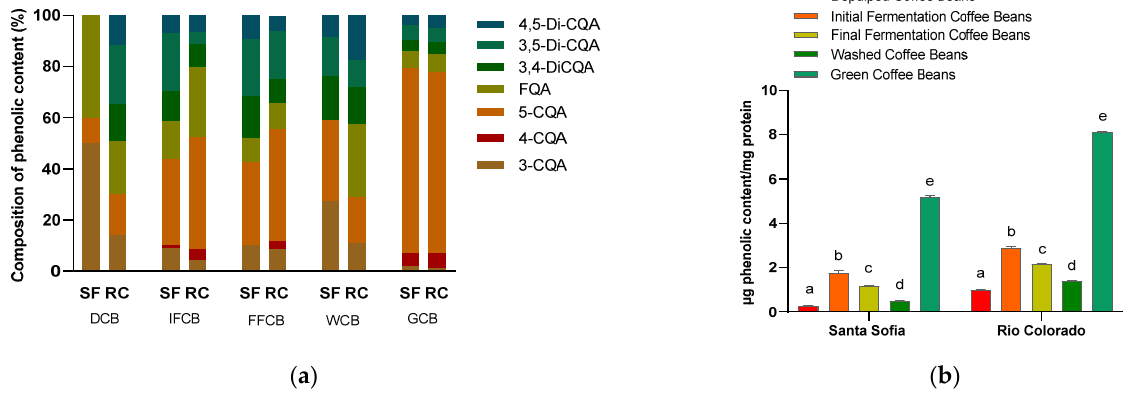
Figure 3. Phenolic compounds in protein extract. ( a ) Composition of the major phenolic compounds expressed as percentage of total phenolic compounds; ( b ) amount of phenolic compounds shown as the sum of means ± standard deviation of the detected phenolic compounds ( n = 3). SF: Santa Sofia Company; RC: Rio Colorado Company; DCB: de-pulped coffee beans; IFCB: initial fermentation coffee beans; FFCB: final fermentation coffee beans; WCB: washed coffee beans; GCB: green coffee beans. Different letters indicate significantly different values for each group ( p < 0.05, ANOVA, Tukey’s